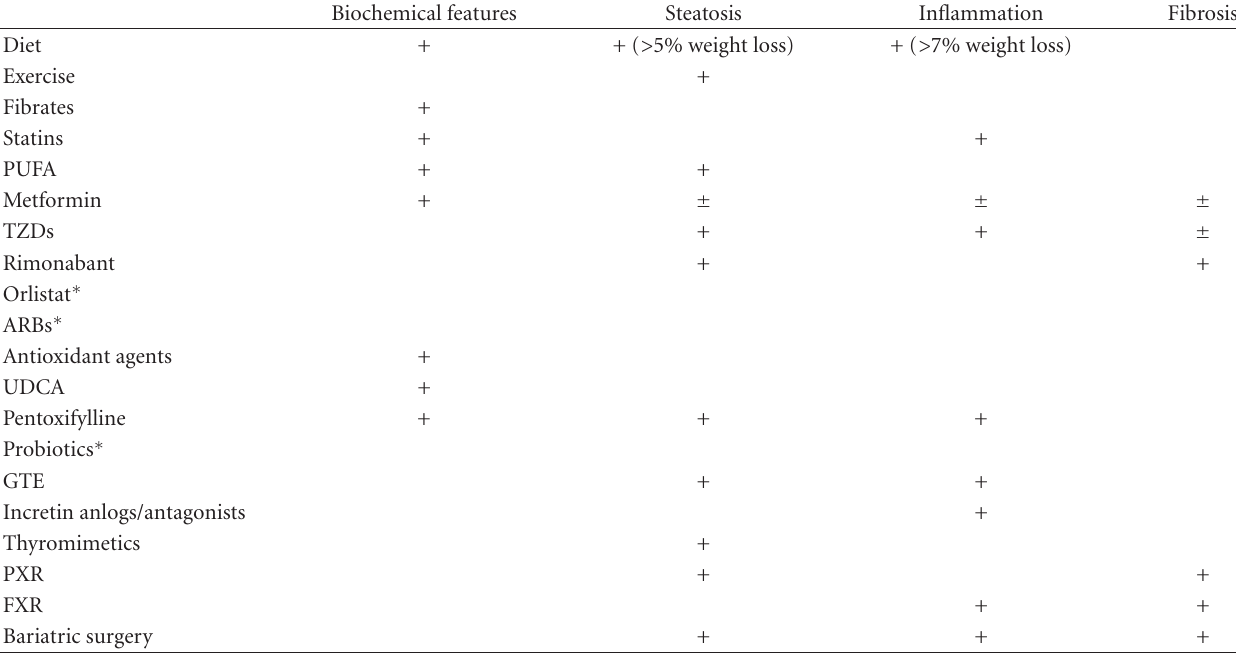
Table 1: Synthesis of possible targets of therapeutic strategies in use and in study for NAFLD. Focus on biochemical, ultrasonographic, and histological features of NAFLD: altered levels of transaminases, steatosis, necroinflammation, and